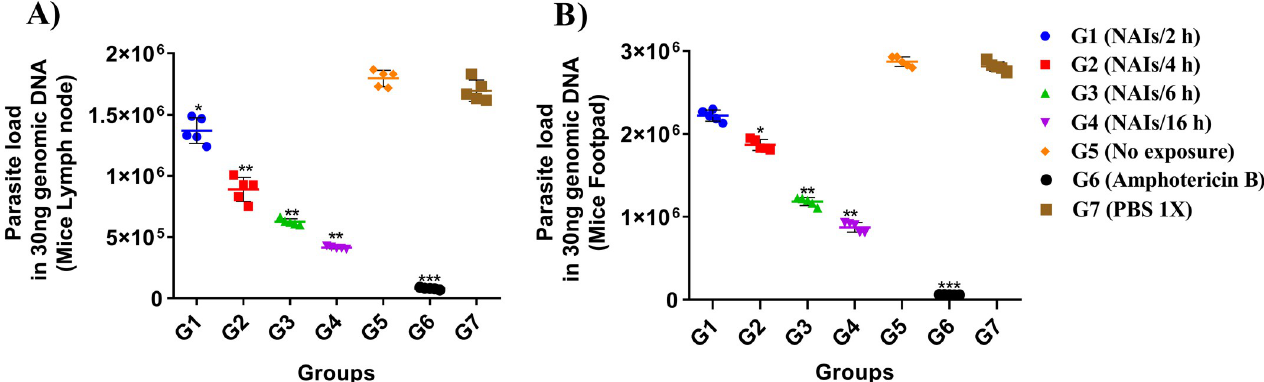
Fig 3. Leishmania major parasite loads in the draining inguinal lymph nodes (LNs) (A) and footpad (FP) (B) of BALB/c mice after NAIs therapy at six weeks post CL infection by using qPCR (after the end of treatment, five mice from each group were randomly selected). All data are reported as the mean ± SD, five mice per group. One of three independent experiments is shown, all presenting similar outcomes ( � P < 0.05, �� P < 0.01, ��� P <